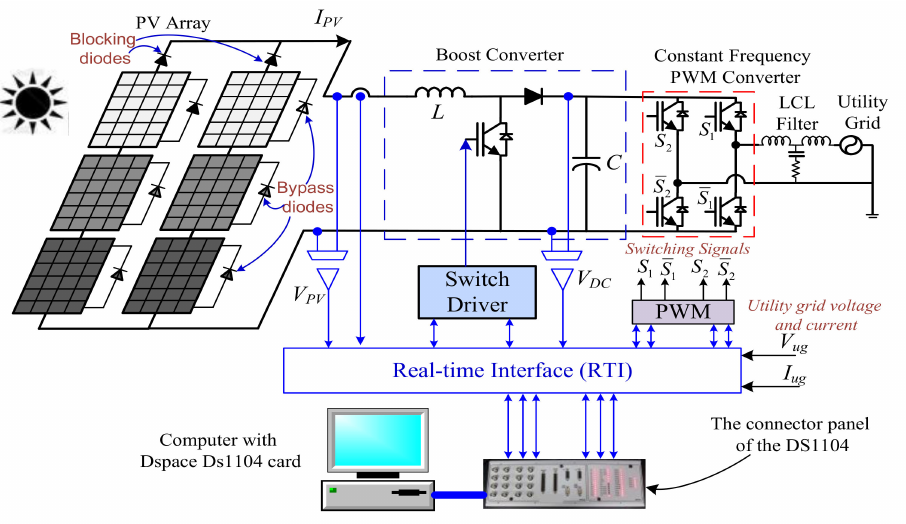
Figure 1. The PV system with MPPT is connected with the utility grid.